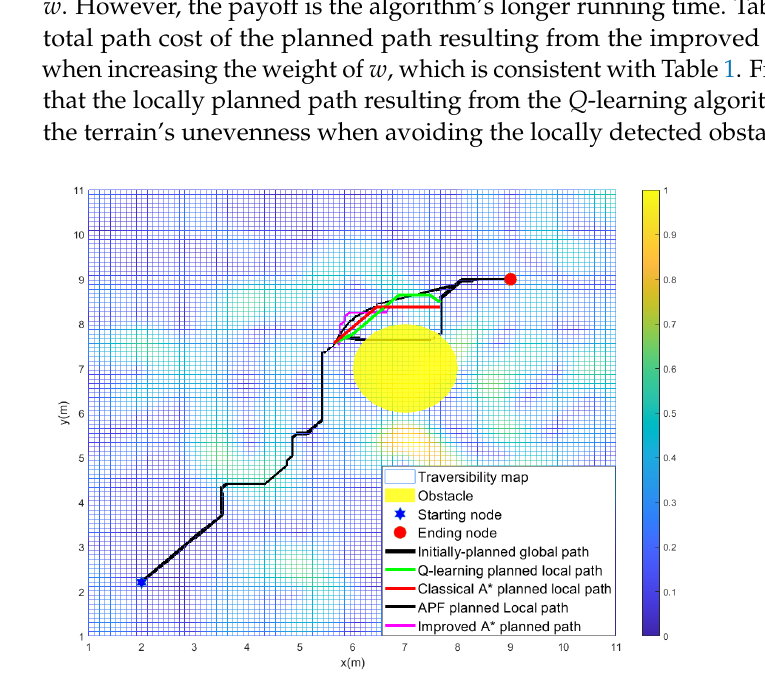
Figure 4. The locally planned path resulting from each algorithm in scenario